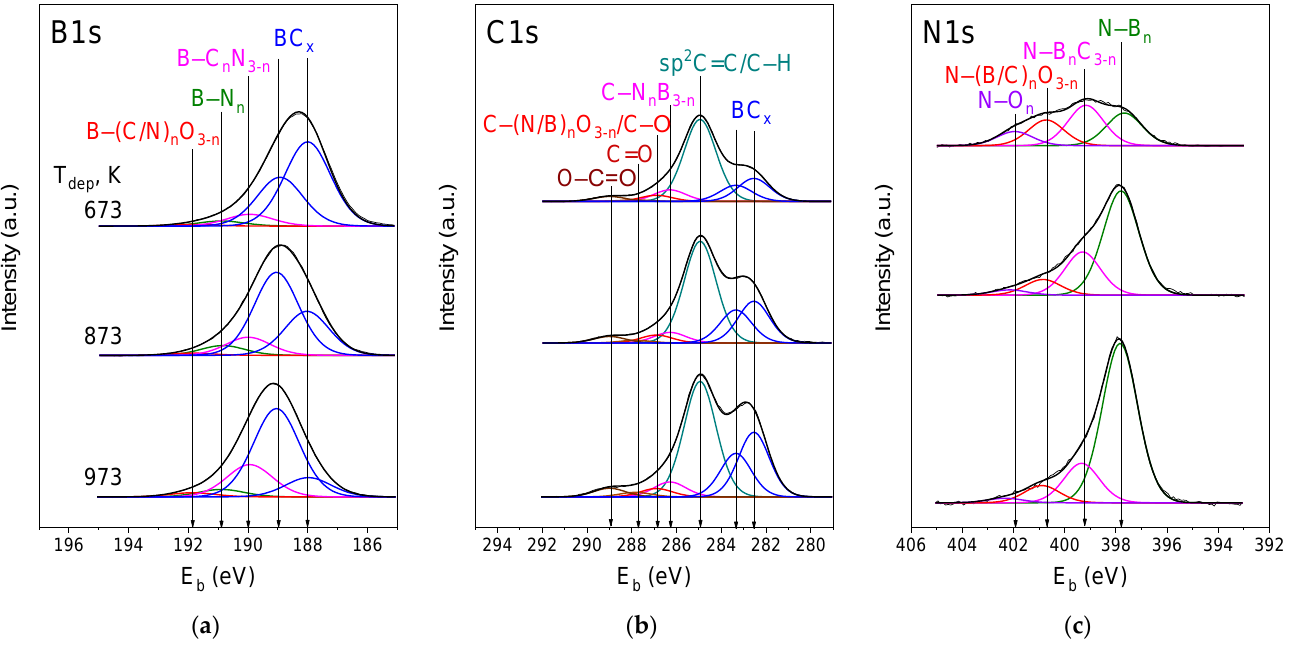
Figure 8. XPS spectra of ( a ) B 1s, ( b ) C 1s, and ( c ) N 1s core levels for LPCVD BC x N y films depos- ited at different temperatures. at different temperatures.